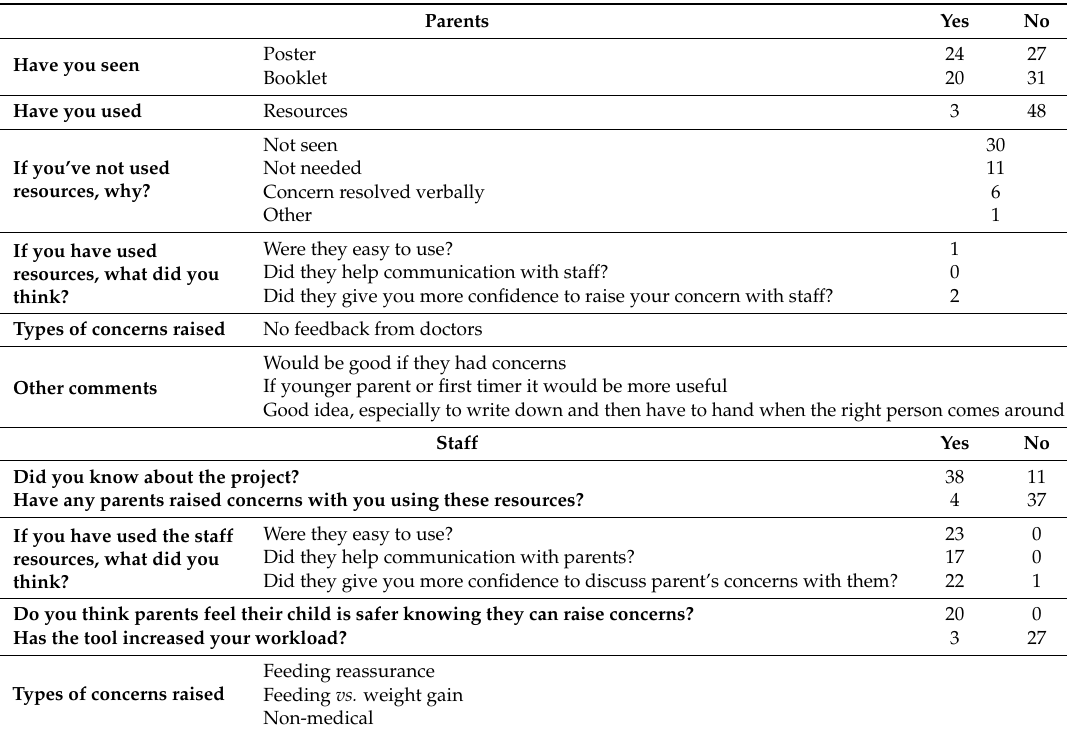
Table 2. Evaluation